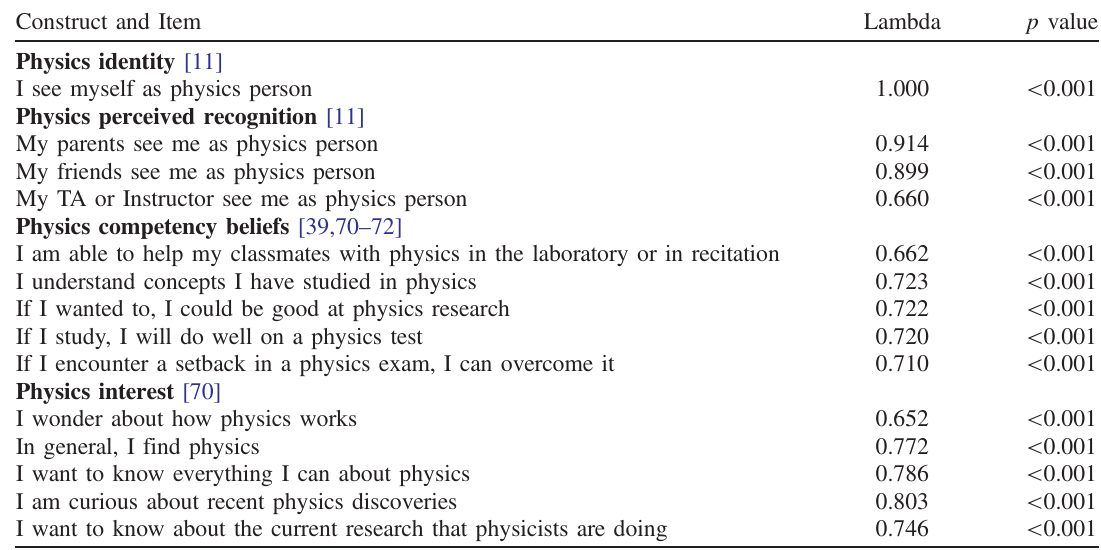
TABLE I. Survey questions for each of the motivational scales, along with CFA item loadings (Lambda and p values of the significance test for each item